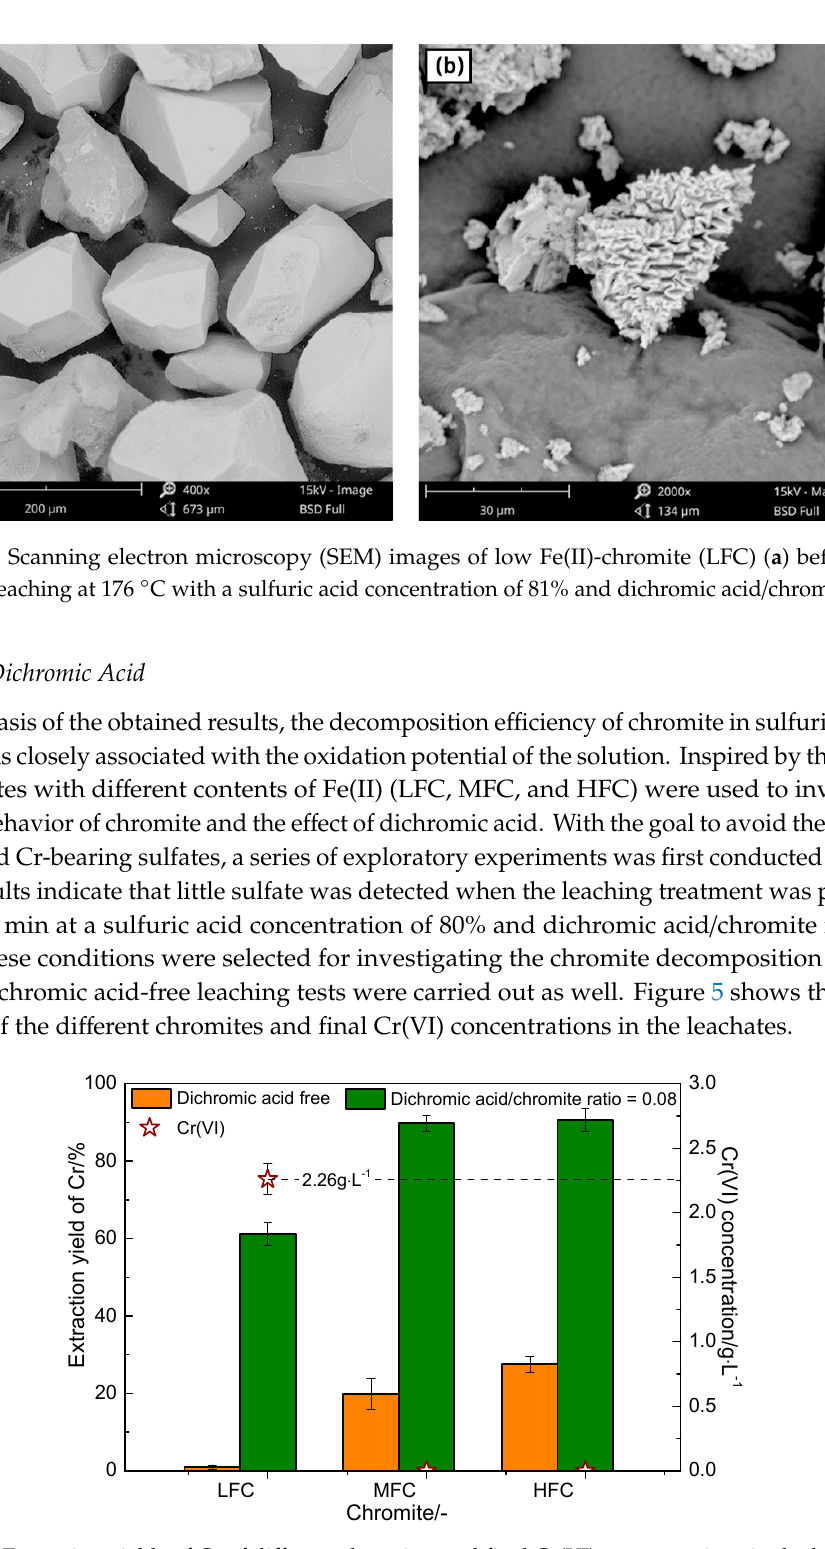
Figure 5. Extraction yields of Cr of different chromites and final Cr(VI) concentrations in the leachates.